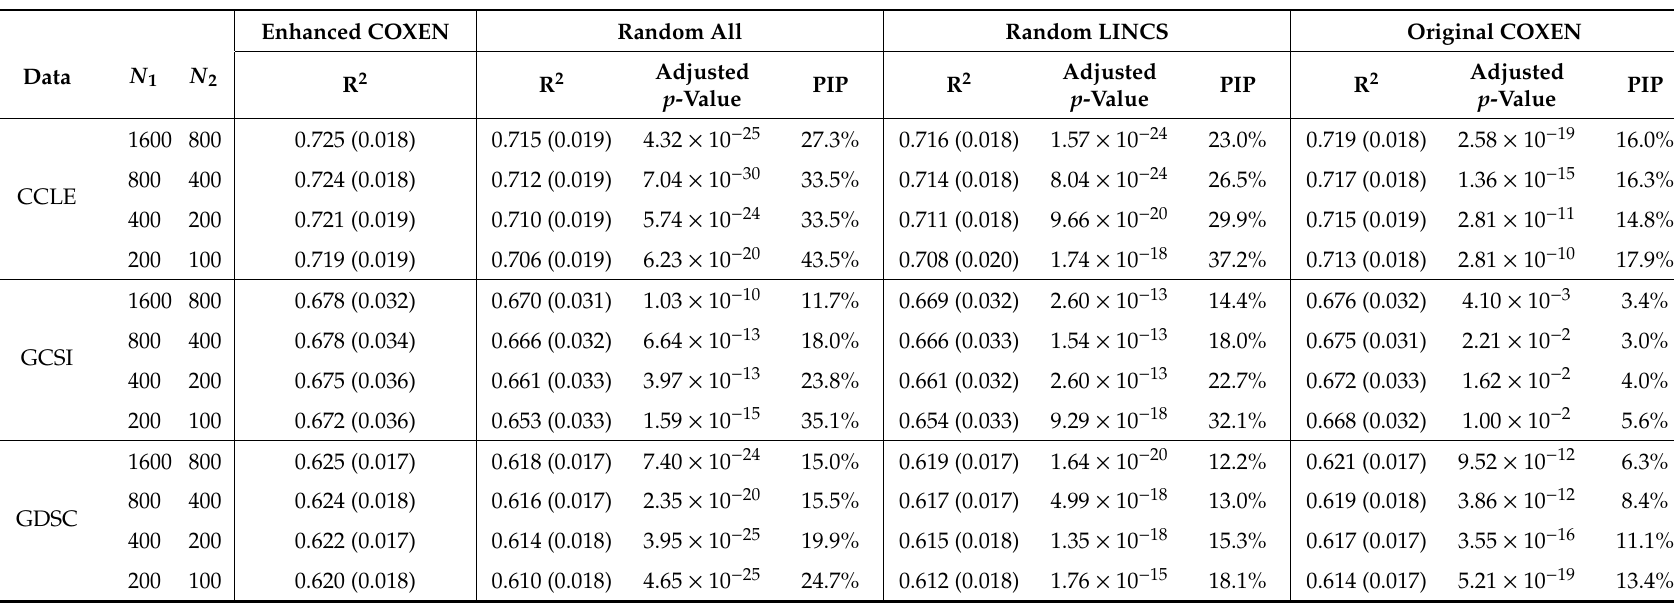
Table 4. Comparison on the prediction performance of models built based on genes selected by the enhanced COXEN method and that of models built based on genes selected by the baseline gene selection